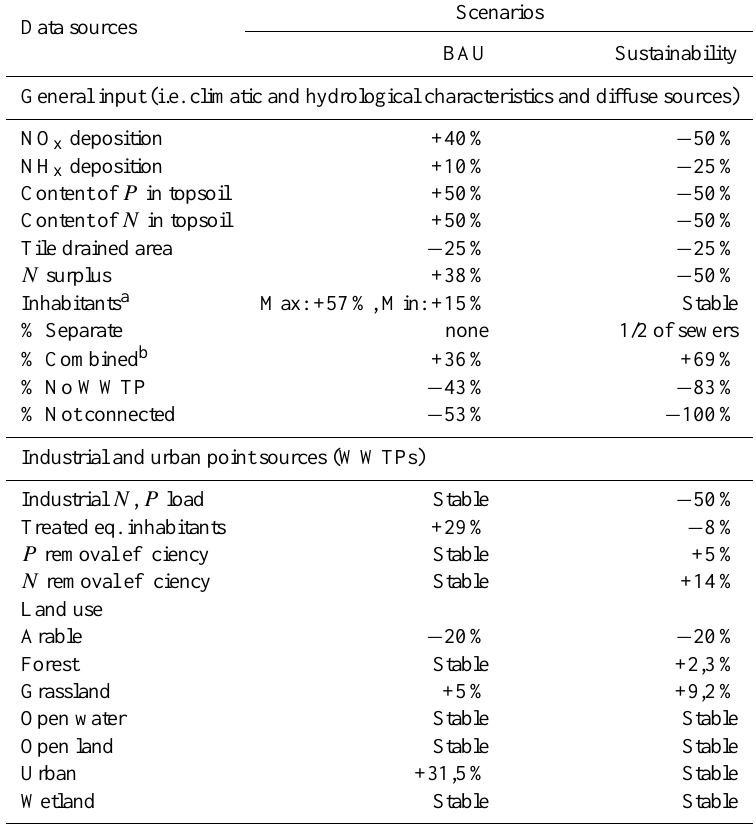
Table 2. Quantification of all the parameters that have an impact on nutrient emissions for the two scenarios elaborated for La Tordera basin. Percent changes refer to the “Current” scenario (see